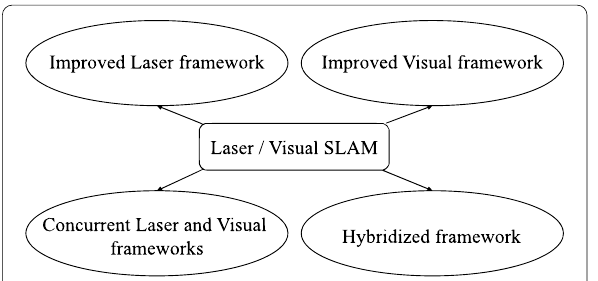
Fig. 1 Various approaches of implementing Laser-Visual SLAM [15]